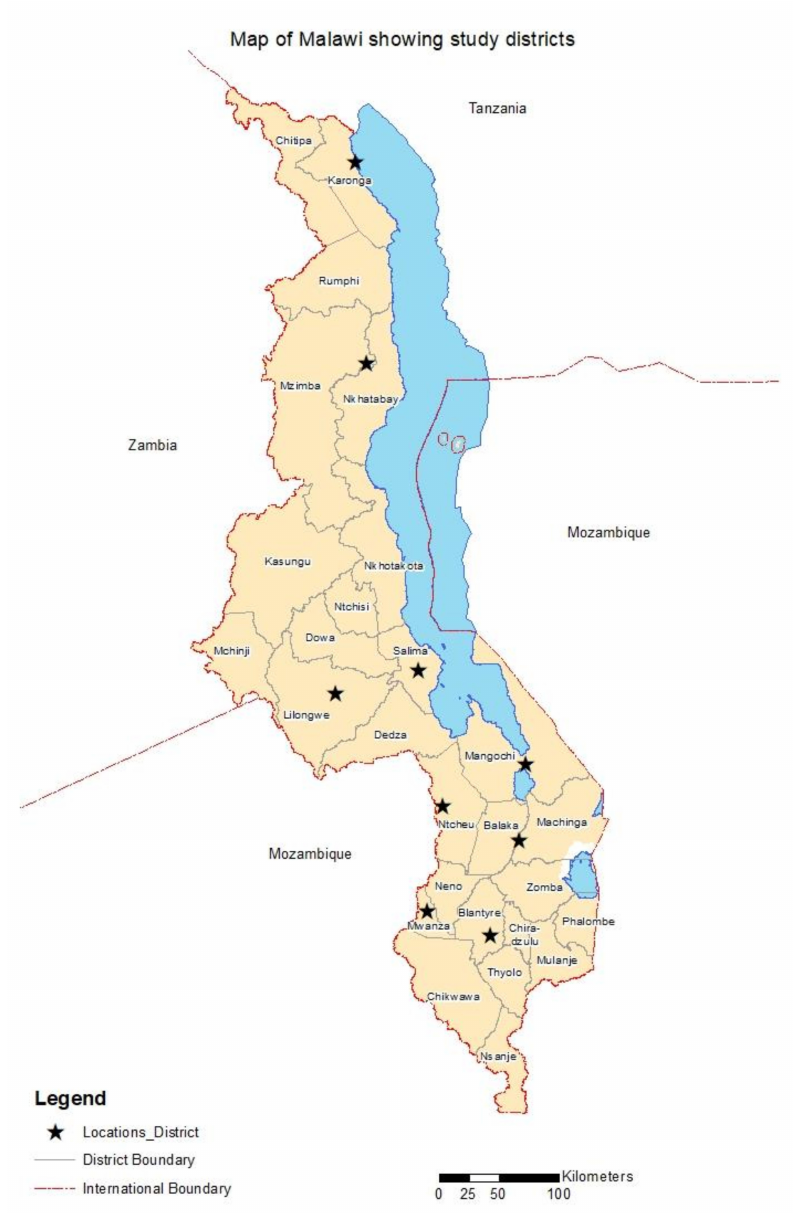
Figure 1. Location of the study